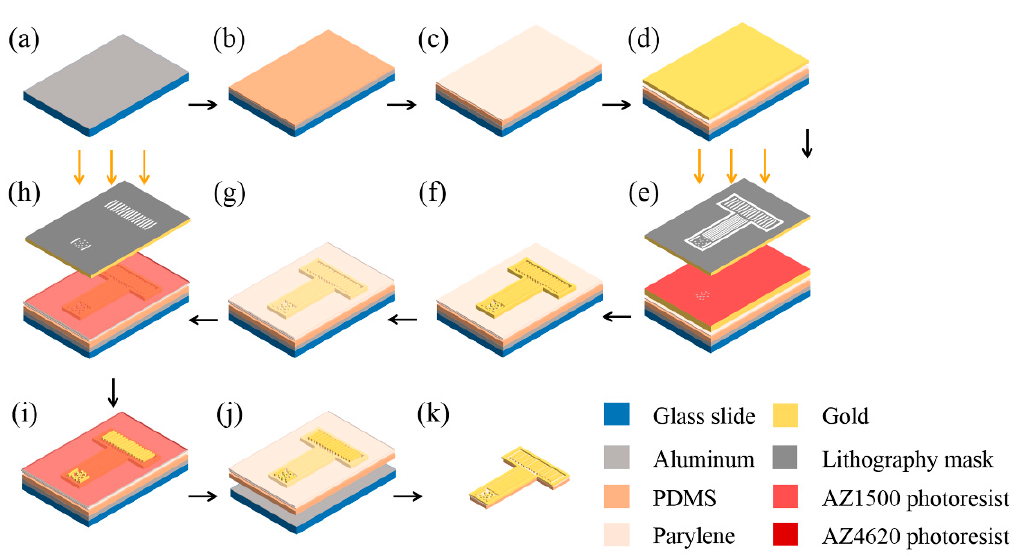
Figure 1. The fabrication processes of the flexible electrocorticography (ECoG) electrode array. ( a , b ) Steps to prepare glass slide and polydimethylsiloxane (PDMS); ( c – f ) Steps to pattern metal layer; ( g ) Deposit insulation layer; ( h – j ) Steps to create openings in insulation layer; ( k ) Release from the glass slide.